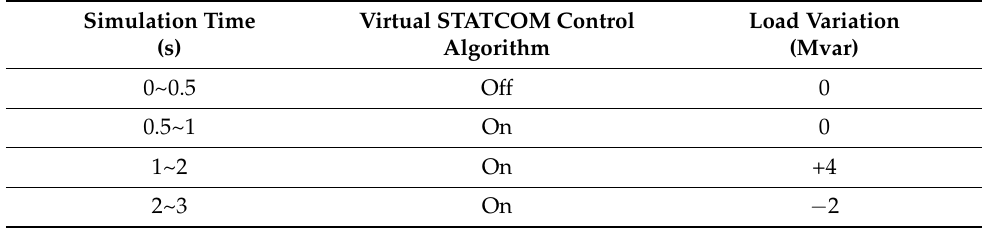
Table 3. Virtual STATCOM Simulation